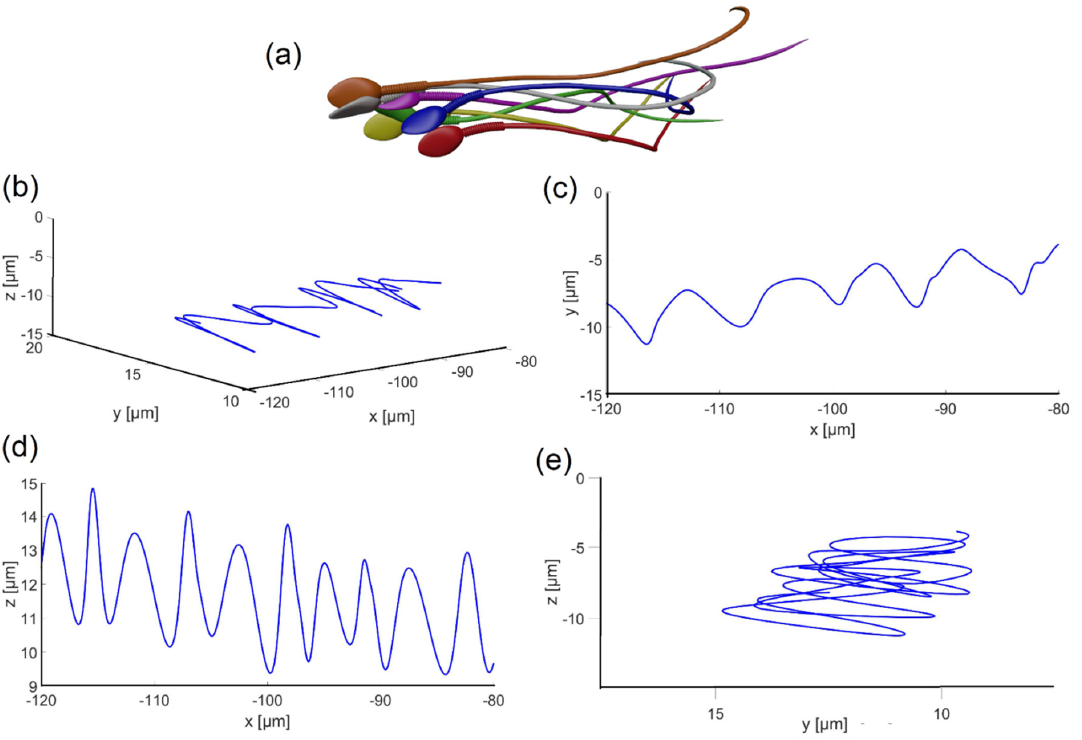
Figure 5. Flagellar beating of the swimming normal model. ( a ) Six frames from the 3D motion of the normal model. ( b – e ) Head centroid path in different planes.